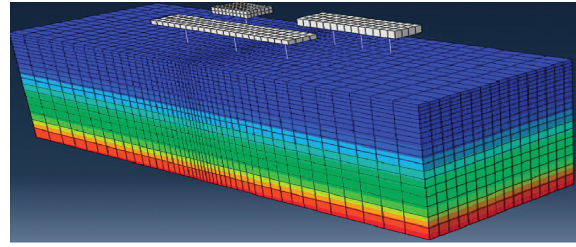
Figure 5: 3D finite element model of the soil-pile-raft